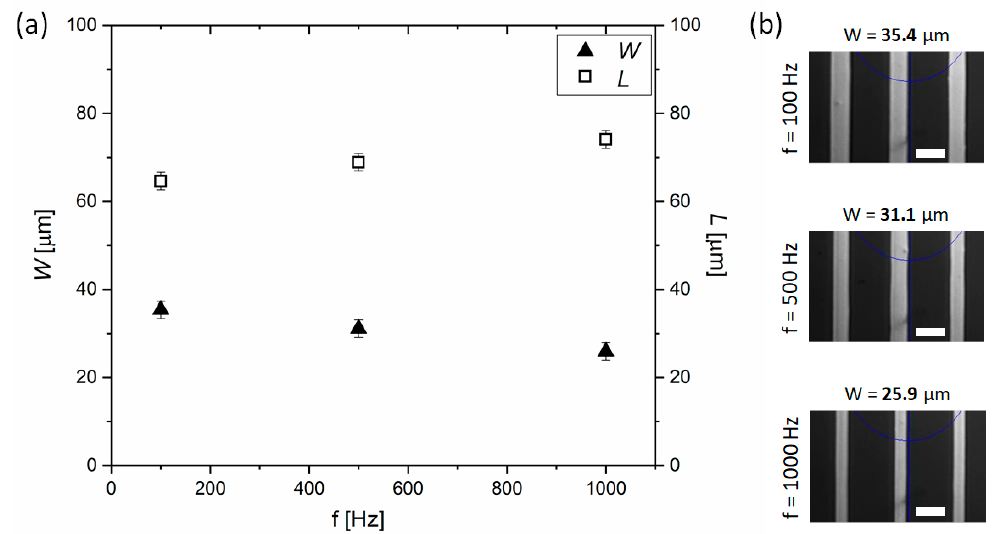
Figure 5. ( a ) Influence of the frequency of the voltage waveform ( f ) on the linewidth ( W ) of the overprints and on the resulting channel length ( L ), for s = 100 µ m. ( b ) Optical microscope images for f = 100 Hz, f = 500 Hz and f = 1000 Hz, respectively. A = 300 V, B = 200 V, s = 100 µ m. Scale bar equal 50 µ m.